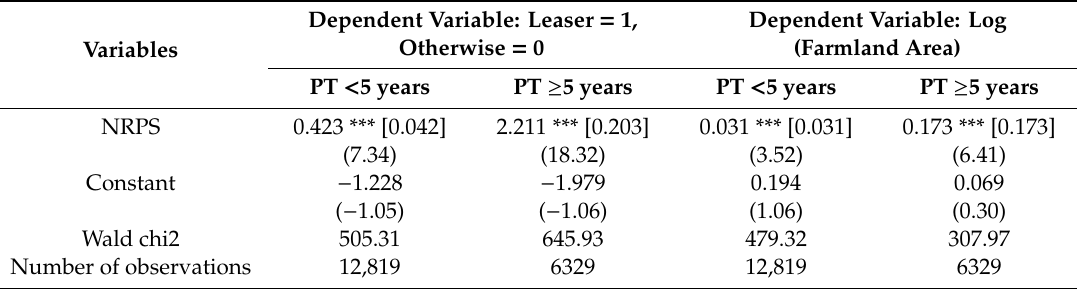
Table 8. Heterogeneity test of participation time (PT) for the NRPS.